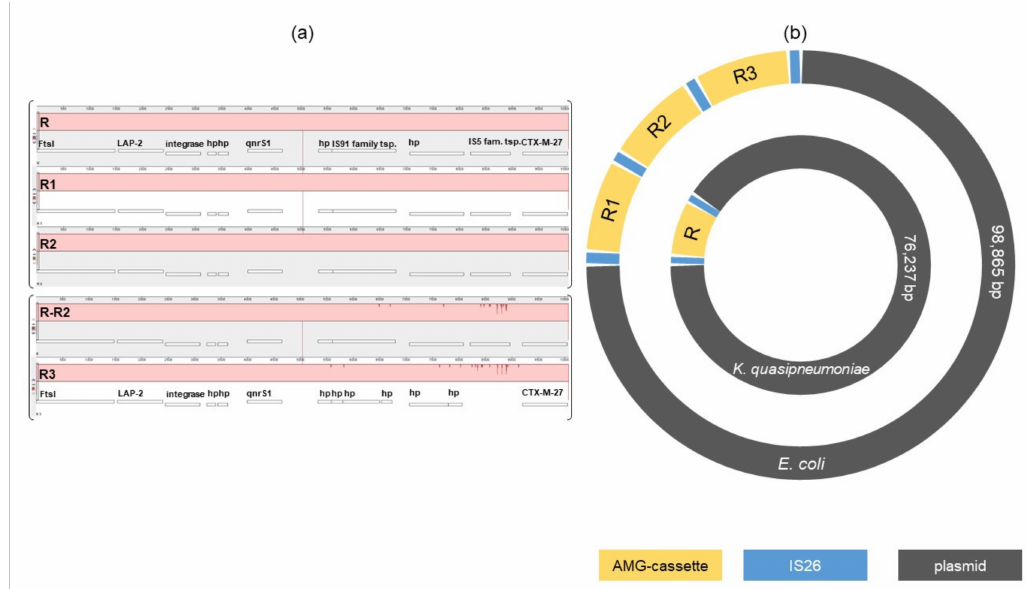
Figure 2. ( a ): progessiveMauve alignment of the AMG-cassettes: R = AMG-cassette of the K. quasip- neumoniae plasmid; R1-3 = AMG-cassettes of the E. coli plasmid; FtsI = peptidoglycan glycosyltrans- ferase FtsI; LAP-2 = bla LAP-2 ; hp = hypotetical protein; qnrS1 = quinolone resistance protein qnrS1 ; tsp. = transpoase; CTX-M-27 = bla CTX-M-27 . IS91 & IS5 family tsp. lost in R3 by frameshift because of insertions and deletions. ( b ): schematic blueprint of the two